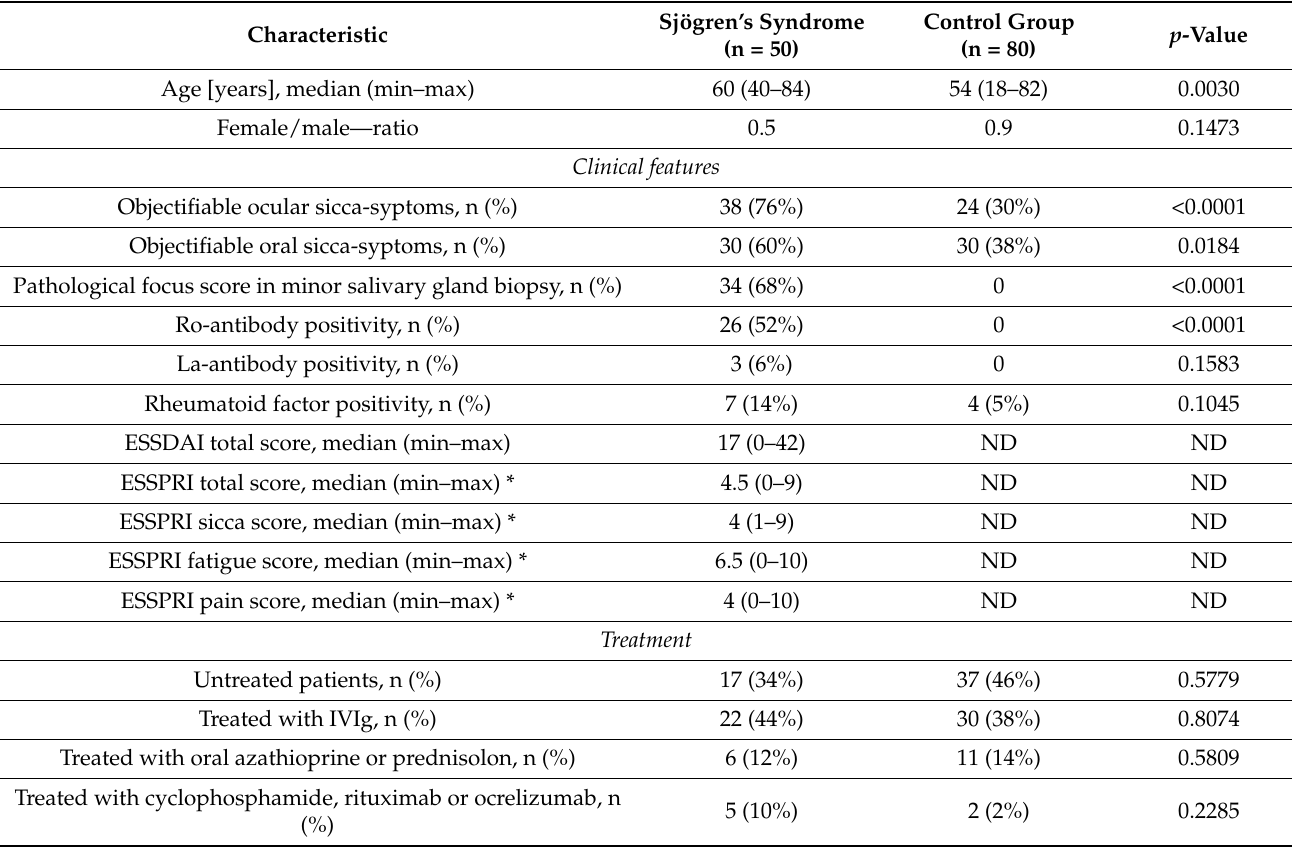
Table 1. Demographic and clinical